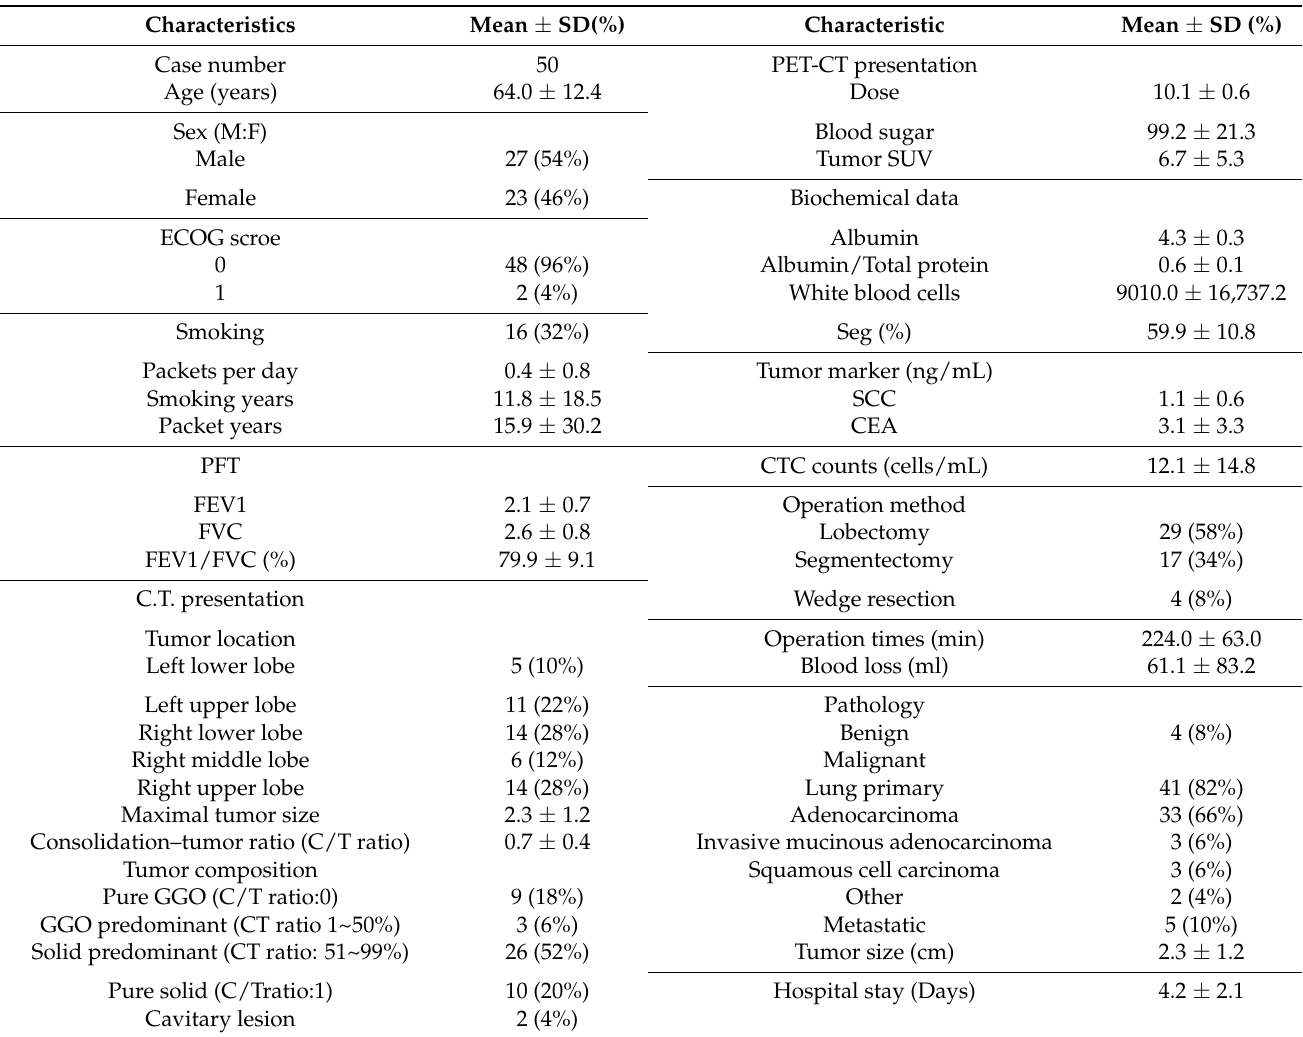
Table 1. Characteristics of whole